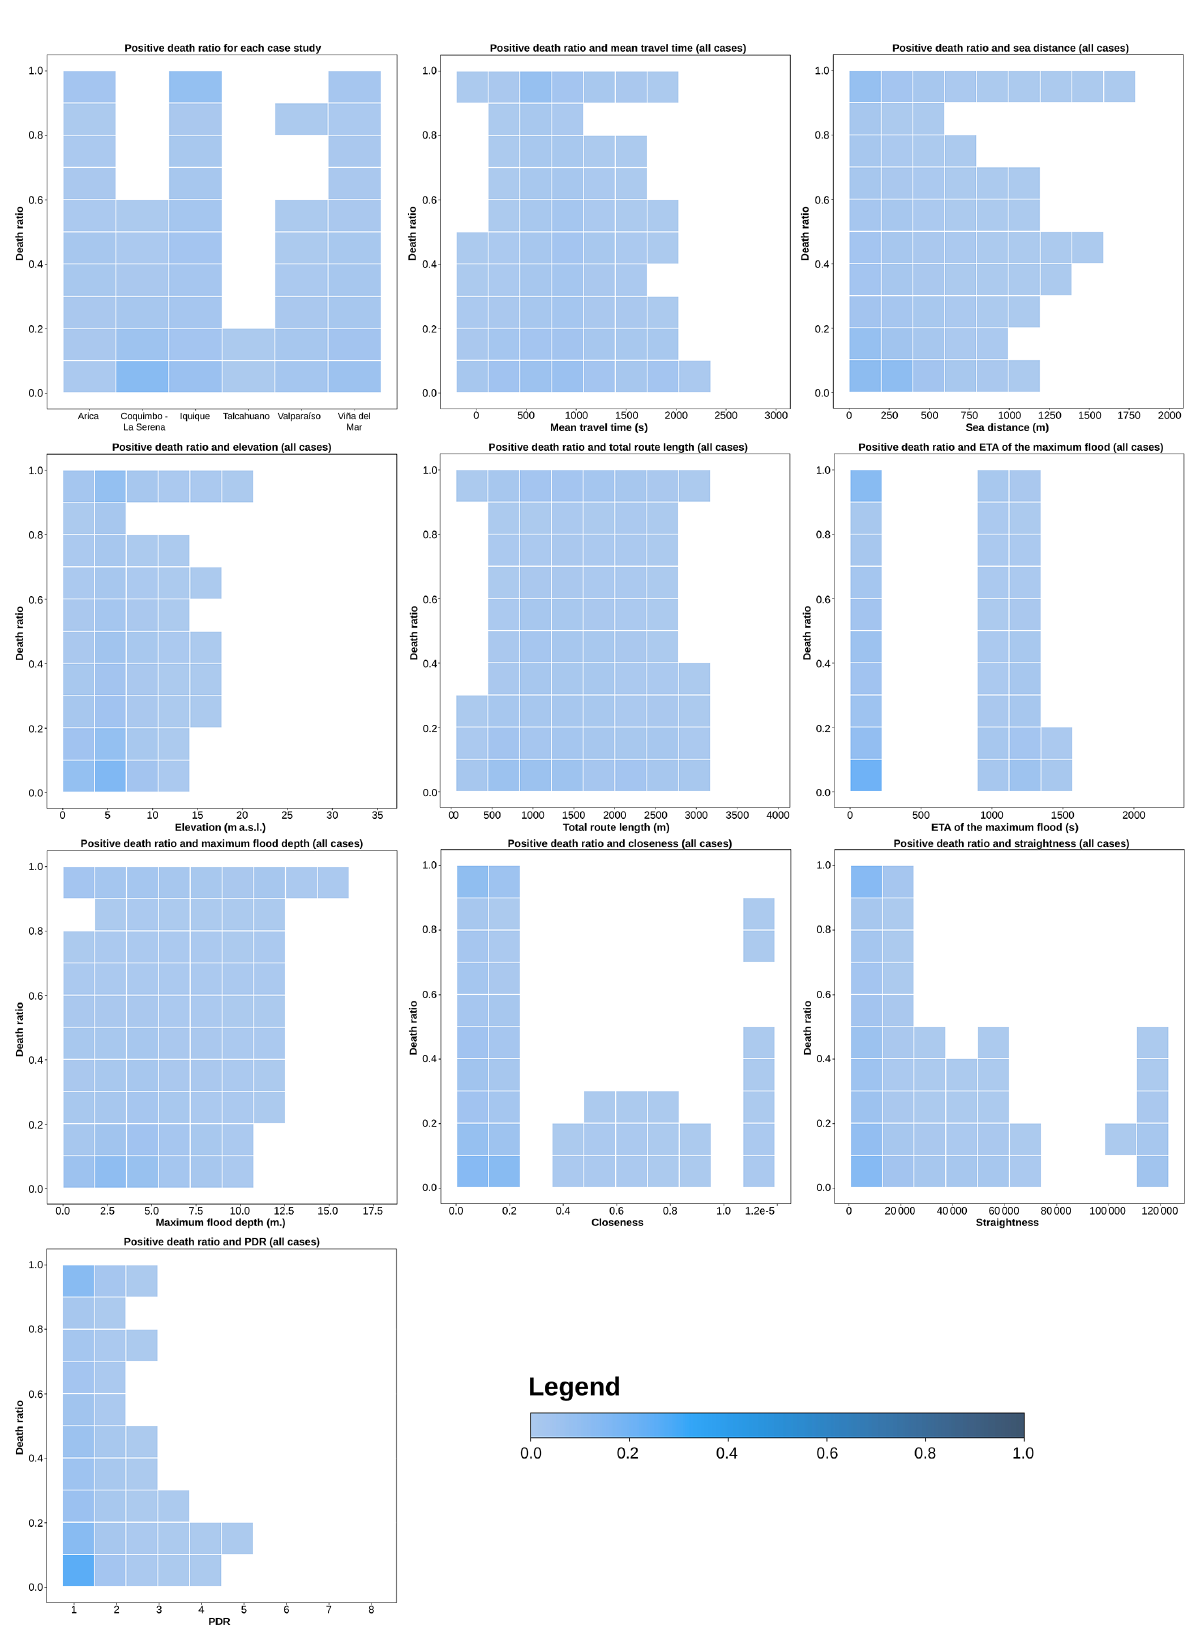
Figure 5. Data scatterplots showing the distribution of the death ratios, in comparison to the nine examined independent variables. The prevalence of different death ratios across the case studies is also included (top left